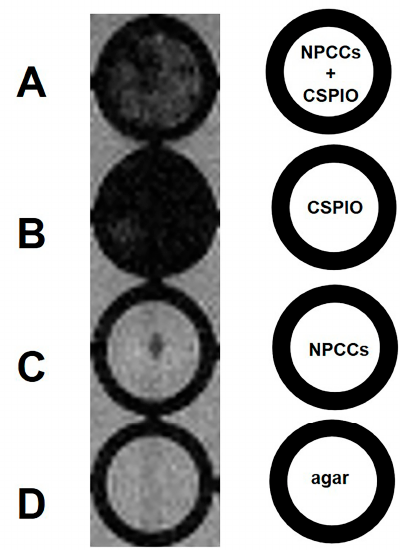
Figure 2. In vitro MRI of 700 NPCCs incubated overnight with ( A ) and without ( C ) chitosan-coated superparamagnetic iron oxide (CSPIO) nanoparticles. CSPIO ( B ) was used as a positive control and agar ( D ) was used as a negative control. All were scanned by a 7.0 T MRI system. In contrast to unlabeled NPCCs ( C ), CSPIO-loaded NPCCs ( A ) appeared as dark spots.